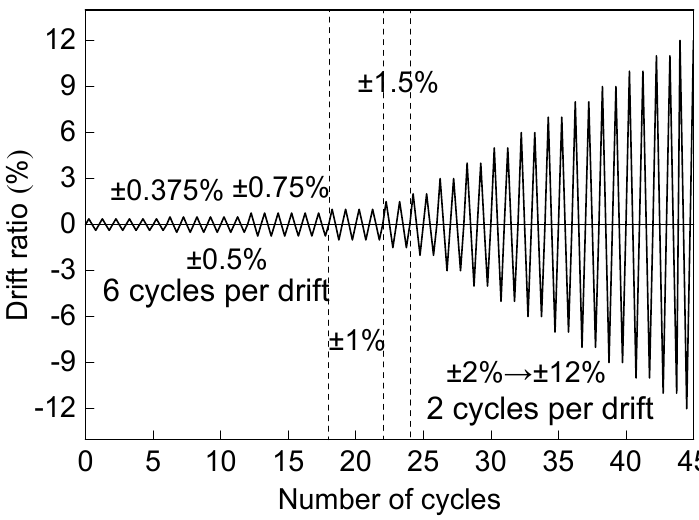
Figure 5. Loading protocol. Figure 5. Loading